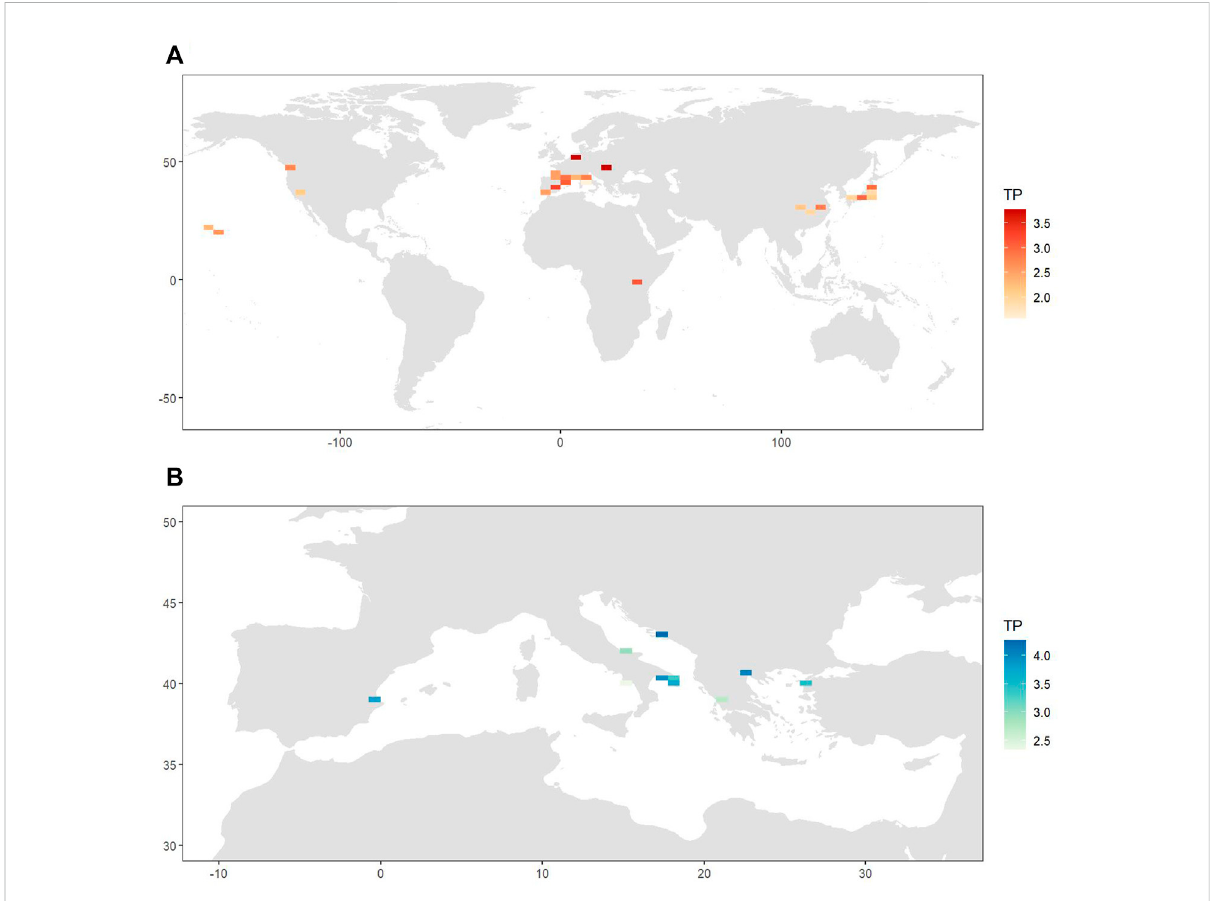
FIGURE 5 Heatmaps showing the values of the trophic position for Procambarus clarkii (A) and Callinectes sapidus (B) calculated respectively using the